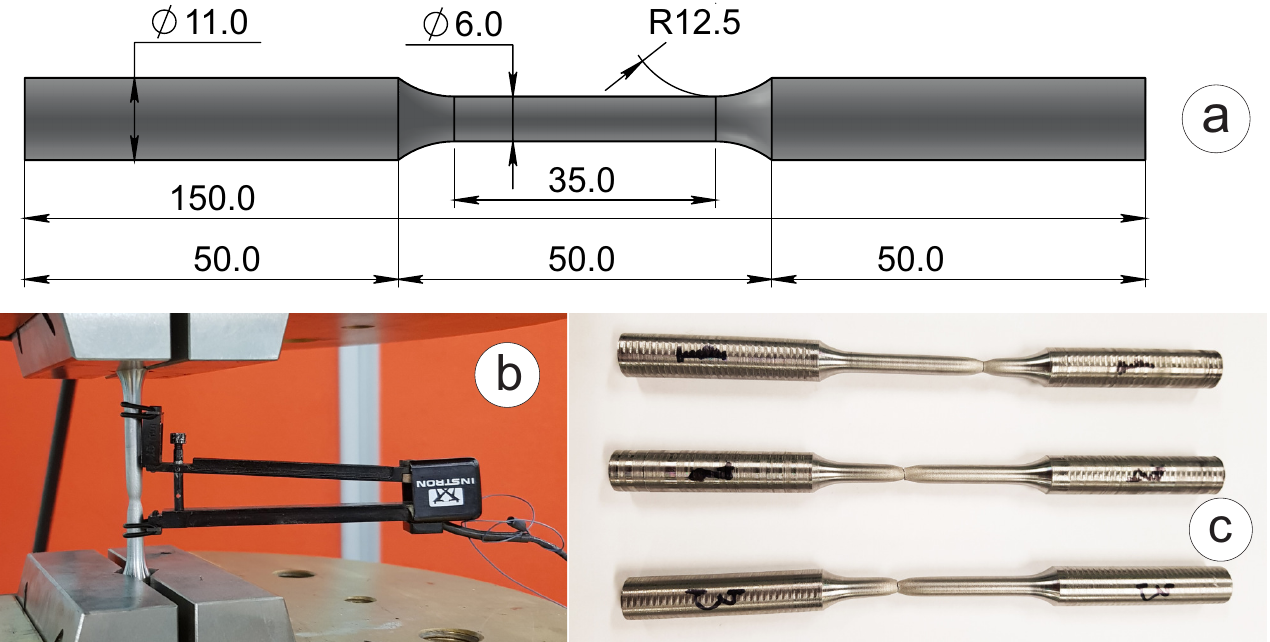
Figure 2. Tensile testing of S275JR+AR steel specimens with corresponding results in Table 1: ( a ) dimensions of the specimen; ( b ) specimen with the strain gauge attached; ( c ) necking of the specimens at